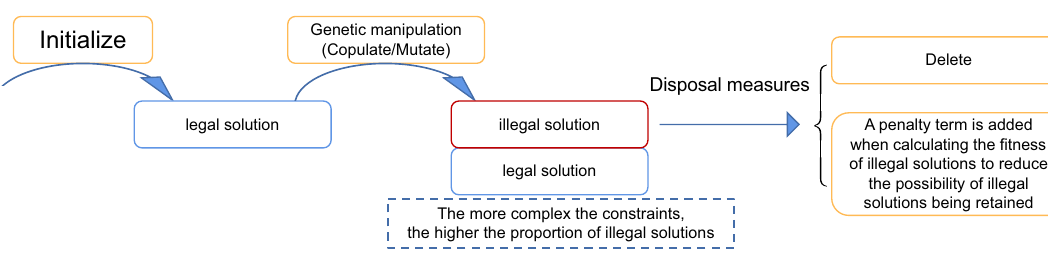
Figure 14. Traditional genetic algorithm search process for solutions.